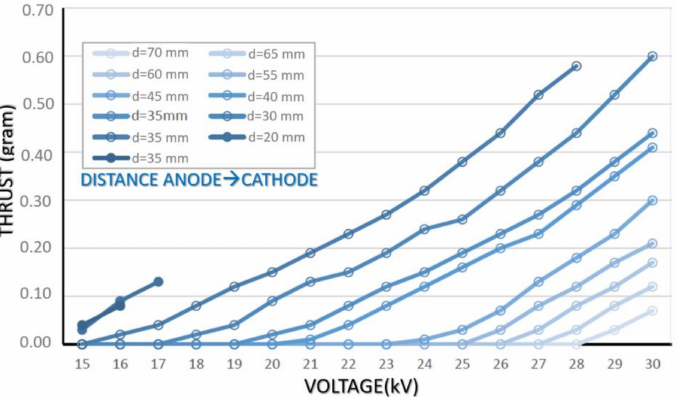
Figure 15. Single thruster (400 mm electrodes): thrust vs. voltage for difference distances between cathode and anode.